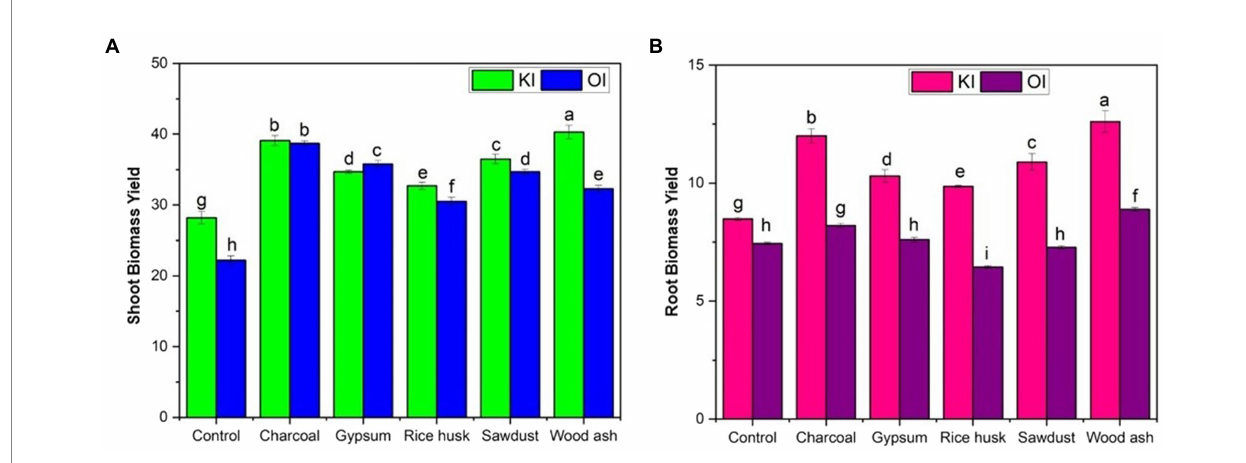
FIGURE 1 Shoot and root biomass yield of coriander plants after soil amendments as affected by (A) potassium iodide (KI) and (B) organic iodine